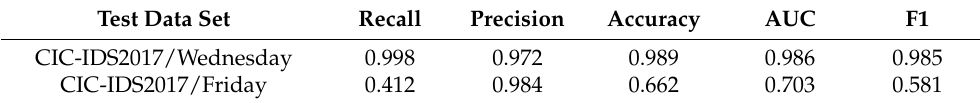
Table 4. Performance of the BI-LSTM trained with “CIC-IDS2017/Wednesday”.